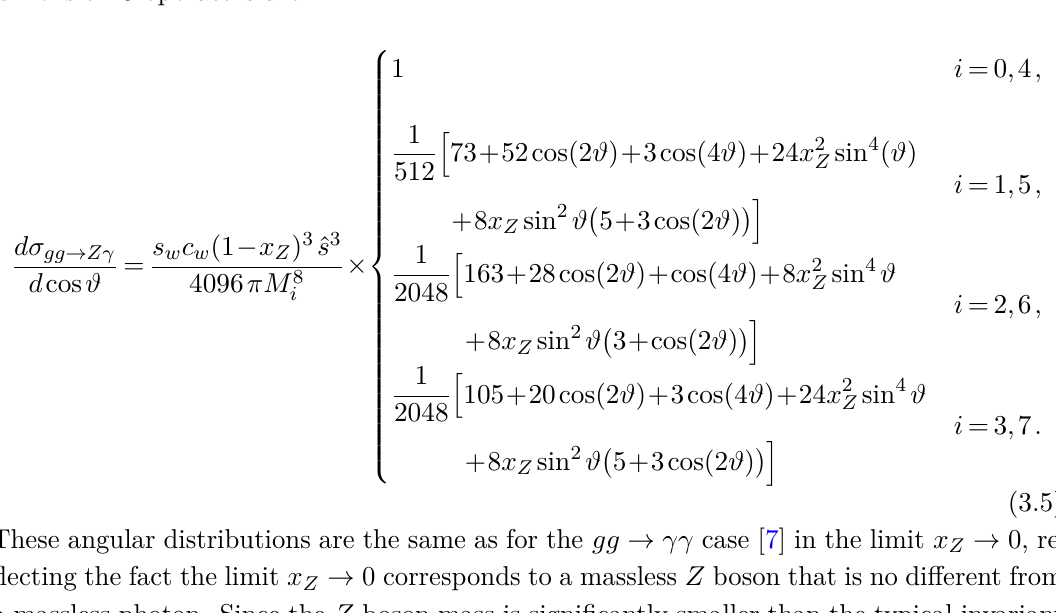
√ √ ˆ s = 100 GeV ) and right ( ˆ s = 1 TeV ) panels.